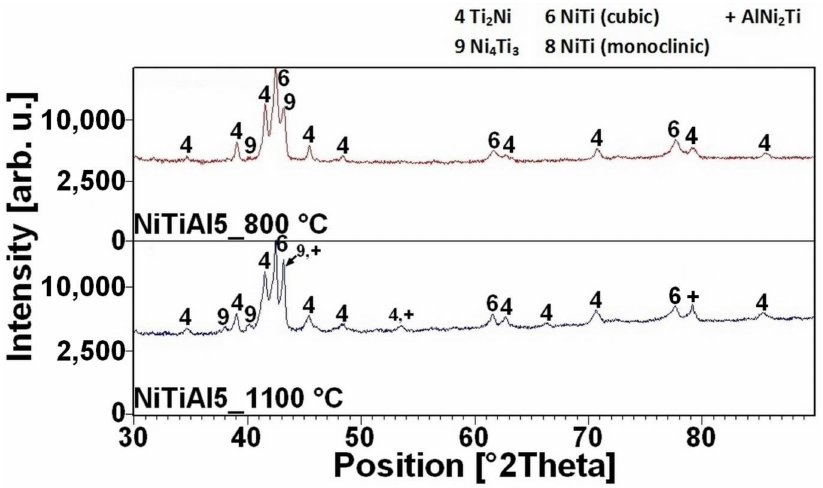
Figure 8. XRD patterns of the NiTiAl5 sample sintered at 800 and 1100 ◦